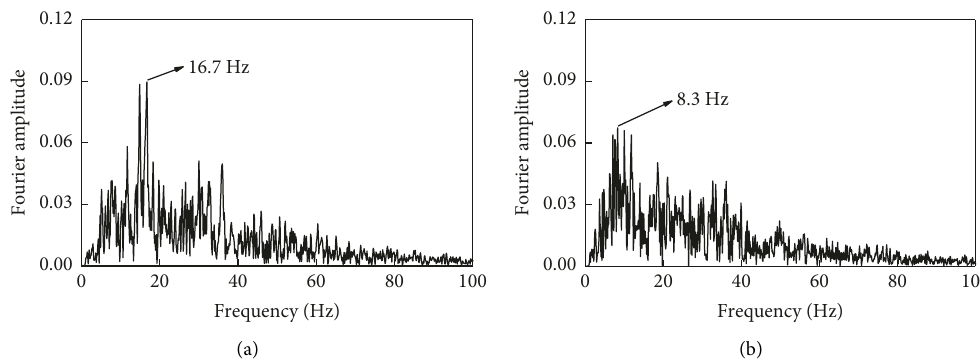
Figure 5: Earthquake wave spectrum for (a) in (x) direction and (b) in (y)